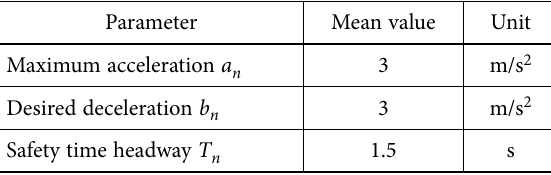
Table 3. IDM simulation parameters